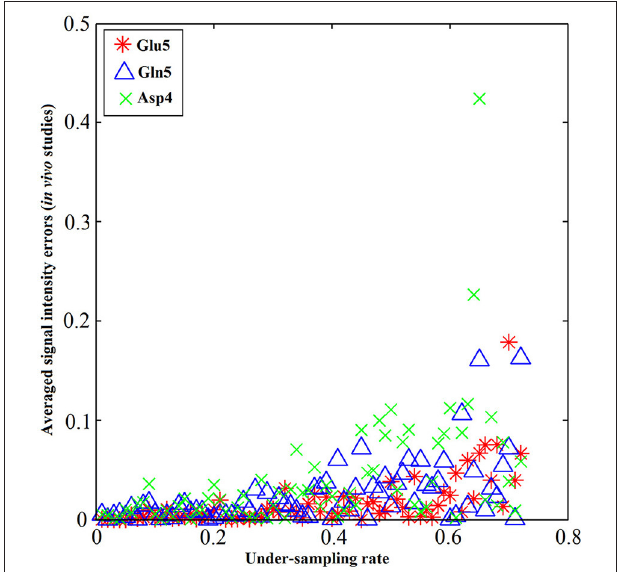
FIGURE 15 | Metabolite concentrations vs. under-sampling rate from in vivo studies. The absolute value of signal intensity errors averaged over 4 different subjects of Glu C5 (star), Gln C5 (triangle), and Asp C4 (cross) increases as the under-sampling rate increases. The signal intensity errors for all three tested chemicals are within 5% when the under-sampling rate is less 32% in general. Similar increase trends of signal intensity errors were observed across all three chemicals as the under-sampling rate increases. Adapted from Li et al. [